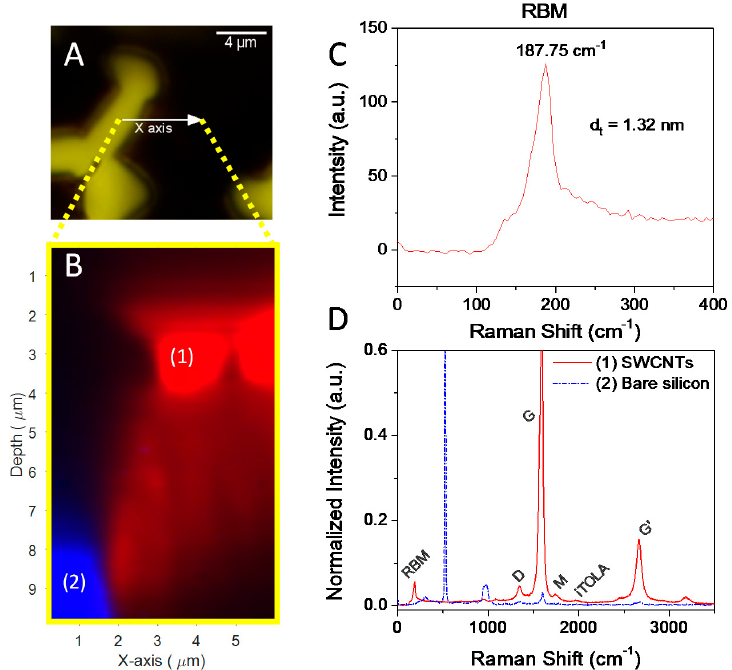
Figure 7. Optical image of the synthesized SWNTs (arrow indicates the analyzed Raman area, and the yellow and black zones correspond to silicon and carbon nanotubes, respectively) ( A ); Raman image analysis performed at di ff erent depths of the sample ( B ); Raman spectrum corresponding to the RBM signal ( C ); and Raman spectra measured in zones marked as (1) and (2) in the blue and red zones of ( B , D